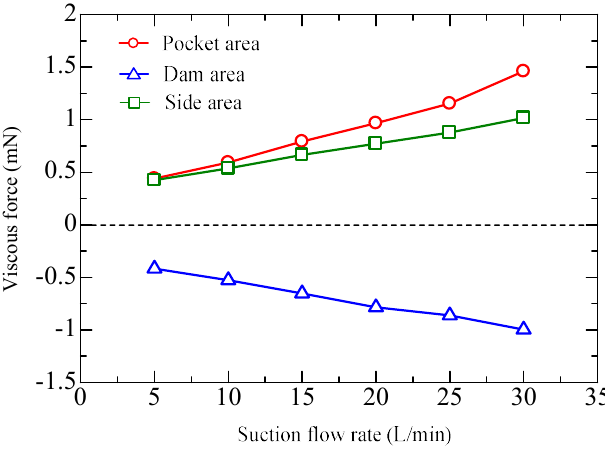
Figure 10. Viscous force contributed by different areas.